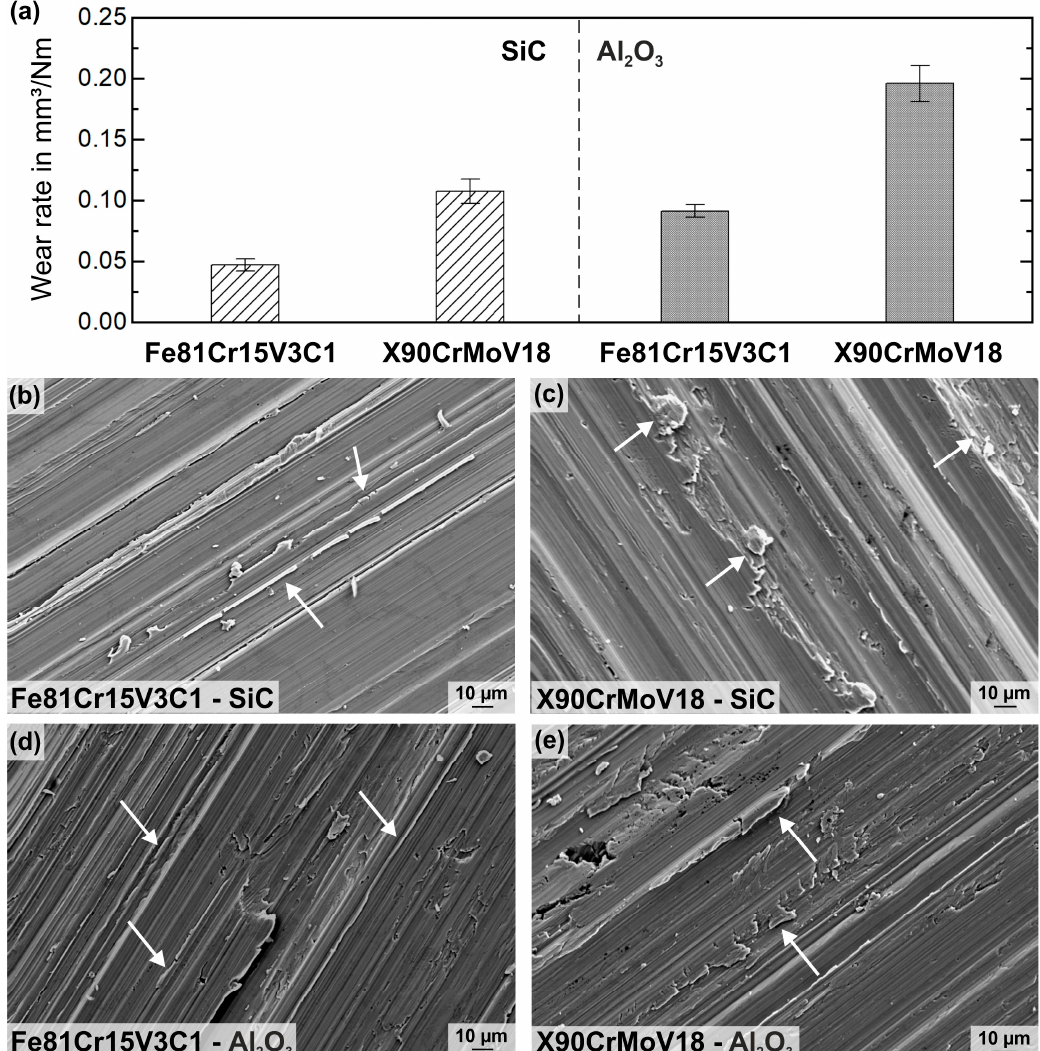
Figure 6. Results of the wear tests with different abrasive counter plates: ( a ) average wear rate, k, of the new FeCrVC cast alloy compared to k of the reference tool steel X90CrMoV18 and ( b – e ) SEM images of worn surfaces displaying wedge formation in different sizes (arrows).